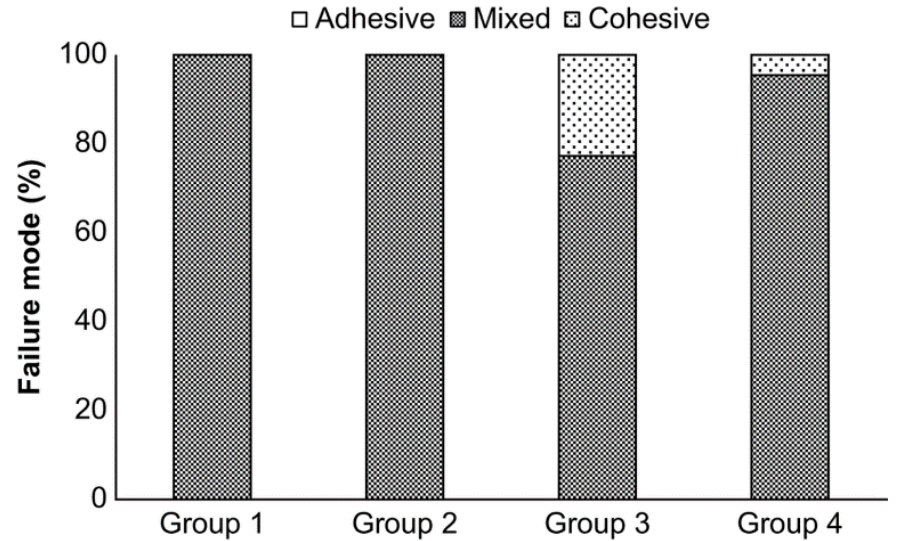
Figure 3. Failure mode analysis of the Group 1–4 samples.